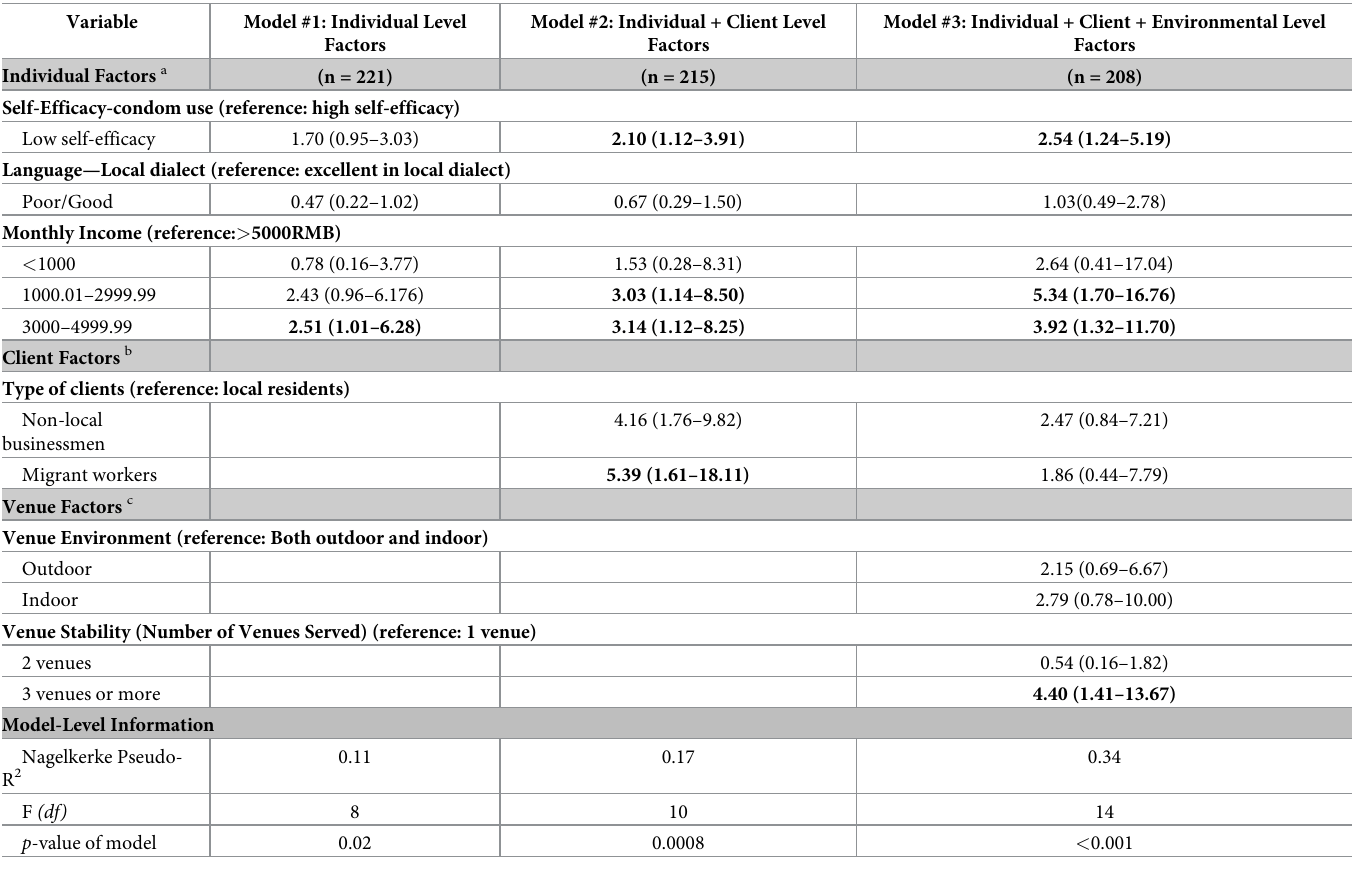
Table 3. Adjusted ORs and the 95% confident intervals of the individual-, client-, and venue-level factors on the street-based sex workers’ infrequent condom use with clients in Shanghai,